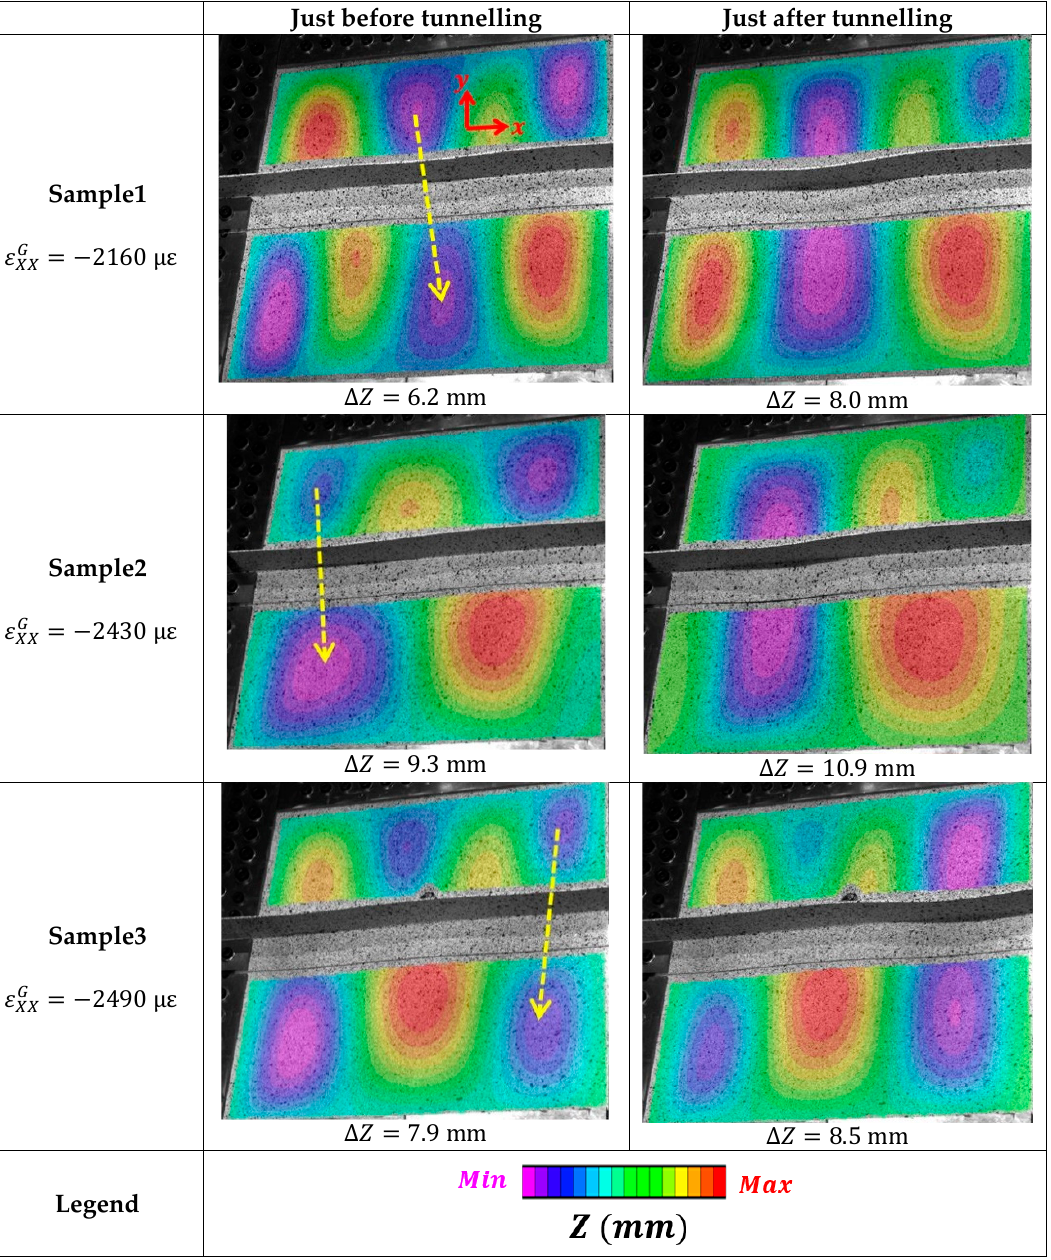
Figure 26. Buckle shapes before and after the first major debonding of the stiffener for each test: tunnelling of negative skin buckles under the stiffener (yellow arrow).